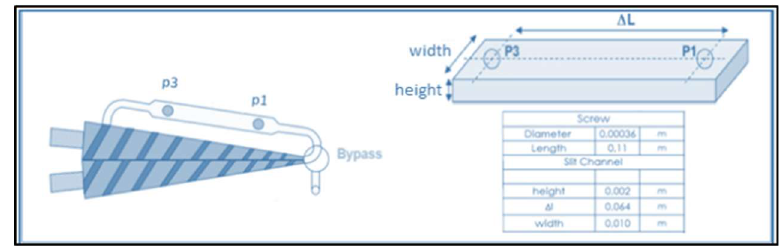
Figure 6. MiniLab Backflow channel and twin-screw conic system.